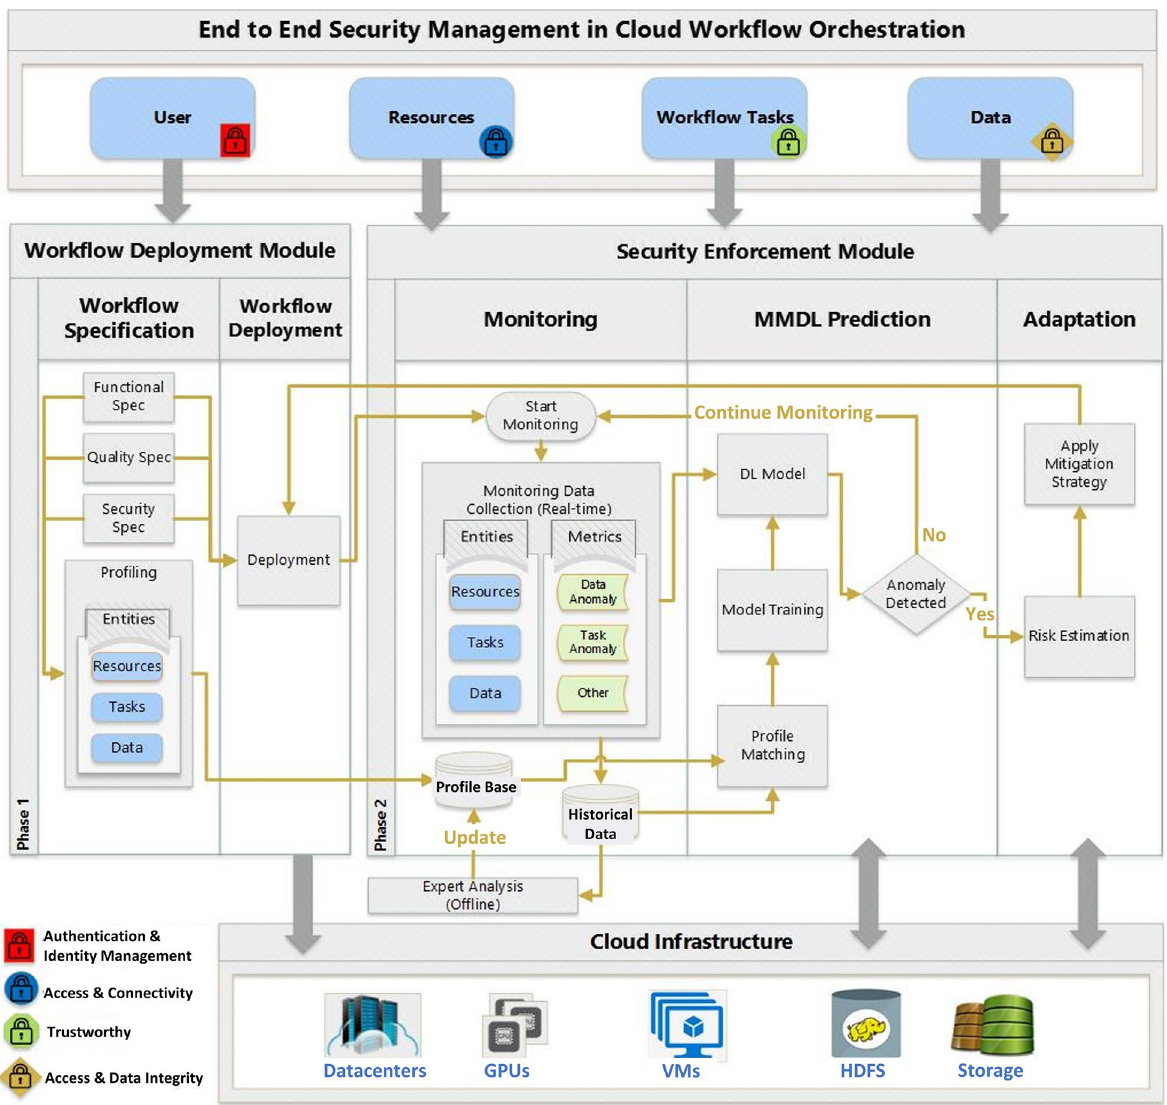
Fig. 2 An architecture for security enforcement in cloud workflow